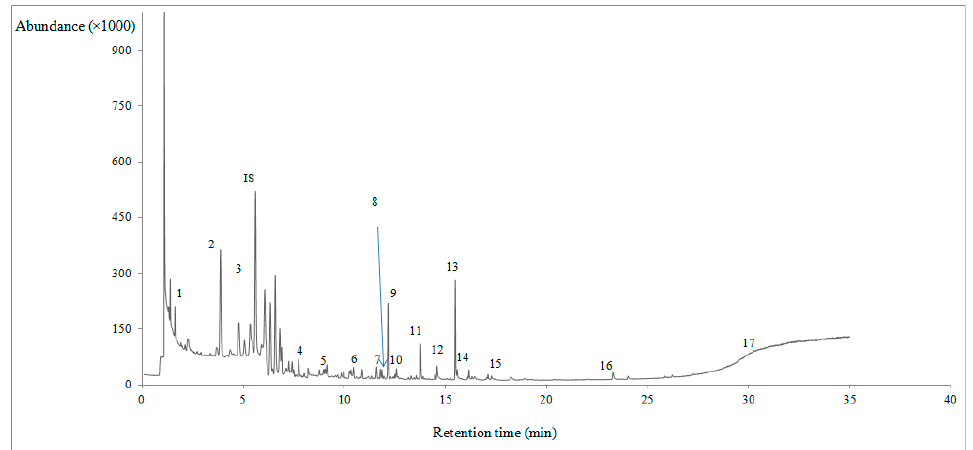
Figure 1. A typical gas chromatogram of raw lamb meat on day 5 of storage. Volatile compounds are